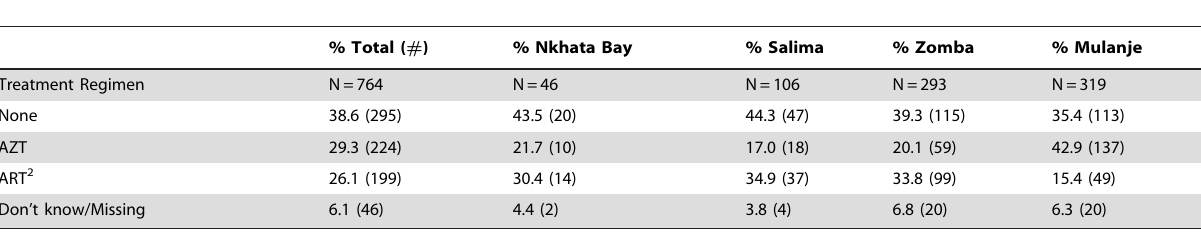
Table 2. HIV Treatment Regimen during